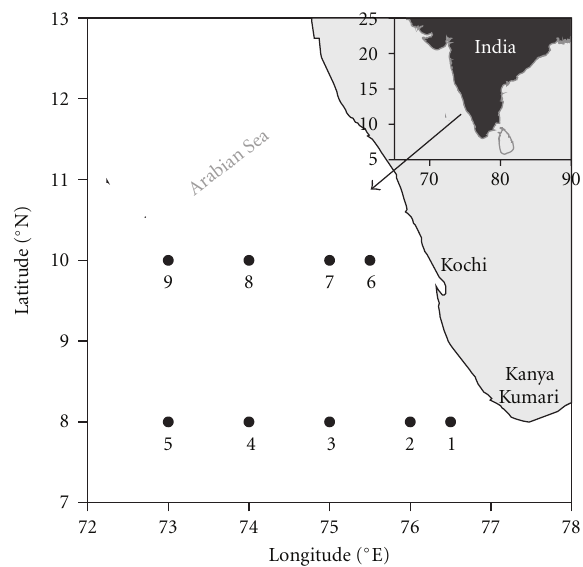
Figure 1: Location of sampling